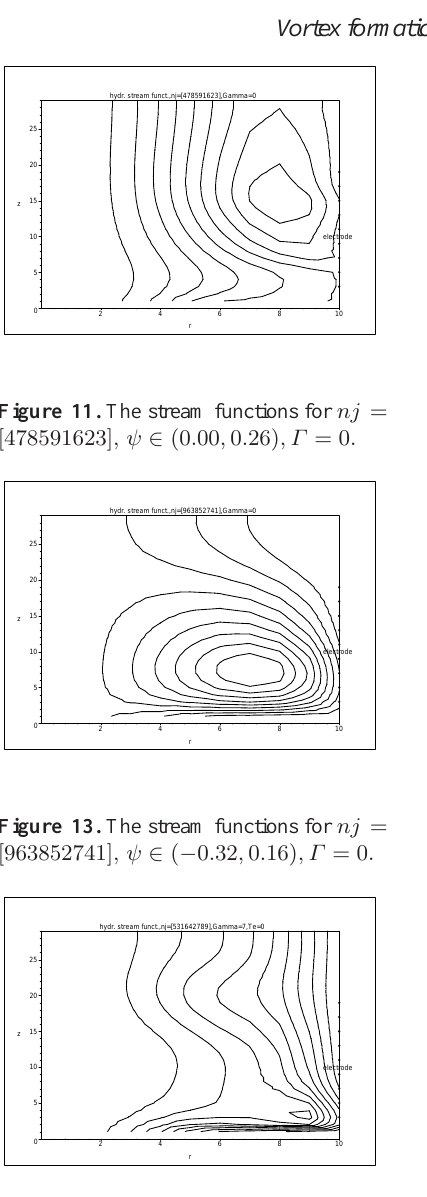
Figure 16. The rotation functions for nj = [147258369] , W max = 0 . 68 , Γ = 2